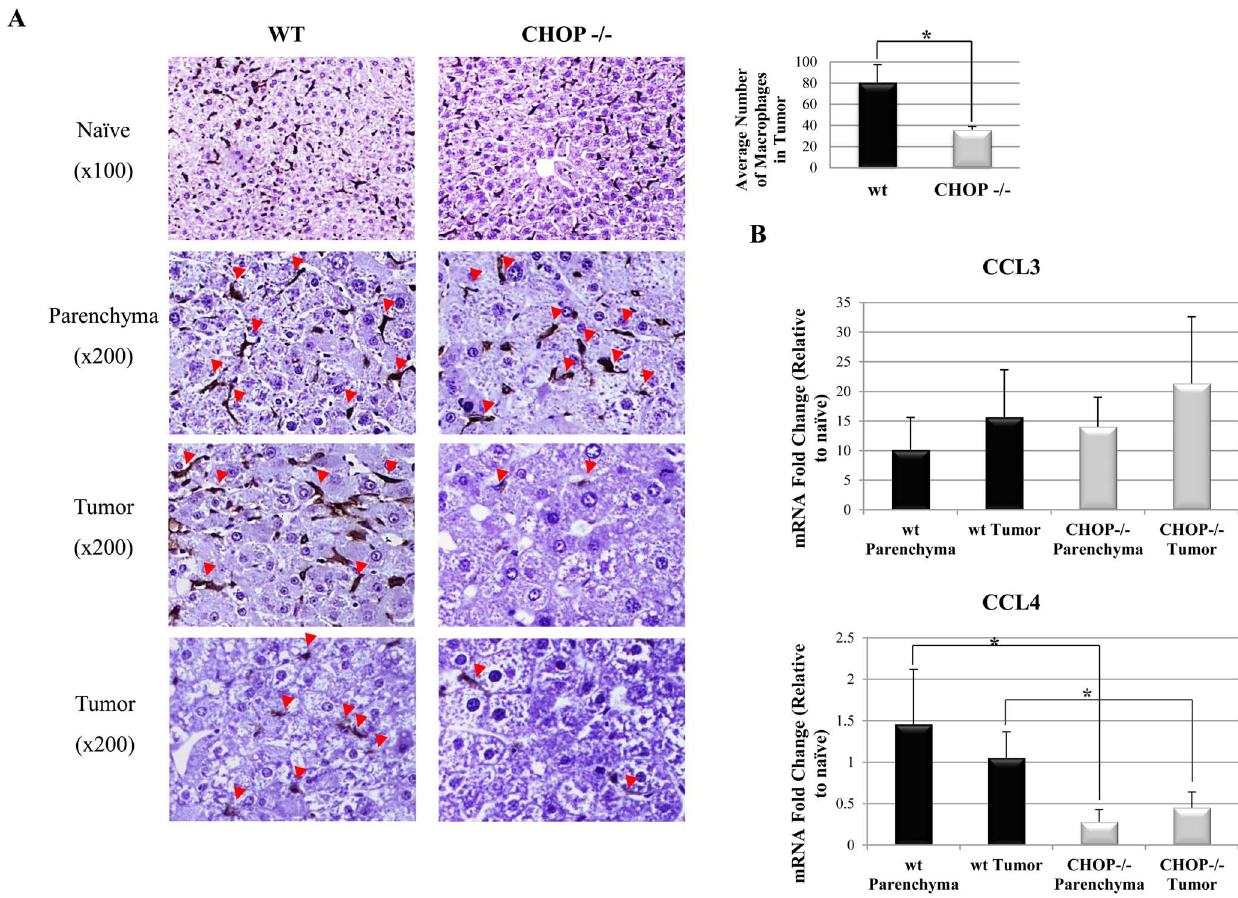
Figure 5. Chemokine levels and macrophages infiltration into DEN-induced HCC. A. Histological sections of WT and CHOP KO livers were stained for the macrophage marker F4/80. Total number of F4/80 positive cells (red arrows) were counted in seven different tumor zones in each sample (n=5 of both genotypes, p , 0.05). B. Analysis of mRNA expression of chemokines in tumor and parenchyma of WT and CHOP 2 / 2 mice.